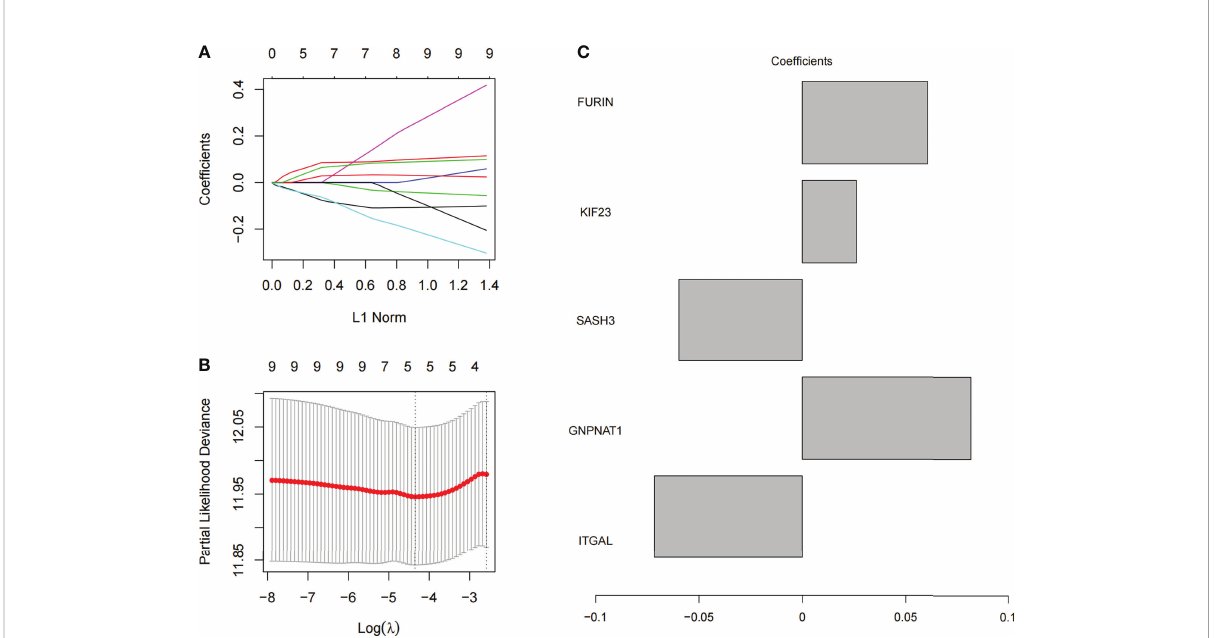
FIGURE 6 Model construction of phagocytosis regulators signature. (A) The coef fi cient of 10 prognostic phagocytosis regulators signature. (B) the partial likelihood deviance of prognostic phagocytosis regulators signature. (C) The coef fi cient display of the 5 phagocytosis regulators signature in the optimal combination